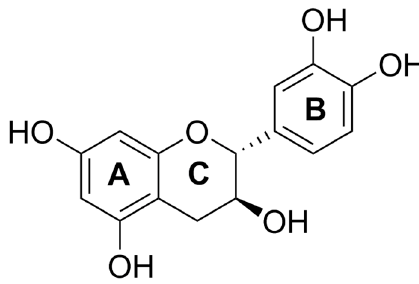
Figure 1. The structure of (+)-catechin.